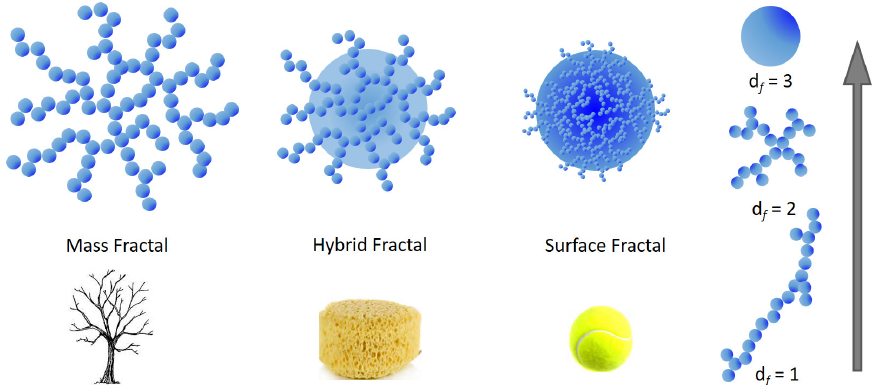
Figure 6. Pictorial representation of mass and surface fractal objects. A mass fractal is depicted by a dendritic structure while a surface fractal is an object similar to a filled tennis ball. Partially penetrable structures (hybrid fractals) can be modelled as a porous sponge. On the right side it is graphically represented how the fractal dimension d f increases from approximately 1 for rod-like aggregates to 3 for ideally spherical structures, passing through intermediate shapes (e.g., d f = 2).